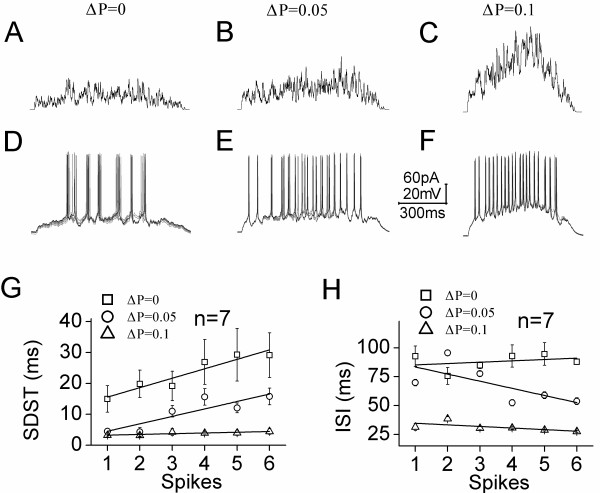
The high increment of release probability during sequential presynaptic spikes enhances the capacity and precision of spike encodings at postsynaptic GABAergic cells. A-C) show the integrated signals from unitary glutamatergic synapses under the conditions of release probability increments (ΔP) about 0, 0.05 and 0.1. D-F) show spike patterns induced by the integrated signals from unitary synapses under the conditions of release probability increments (ΔP) about 0, 0.05 and 0.1. G) shows the comparisons of standard deviation of spike timing (SDST) versus spikes under the conditions of release probability increments (ΔP) about 0 (square symbols), 0.05 (circles) and 0.1 (triangles, n = 7). H) shows the comparisons of inter-spike intervals (ISI) versus spikes under the conditions of release probability increments (ΔP) about 0 (square symbols), 0.05 (circles) and 0.1 (triangles). Calibration bars are 60 pA, 20 mV and 300 ms. Lines in G ~ H illustrate linear dynamical fitting.